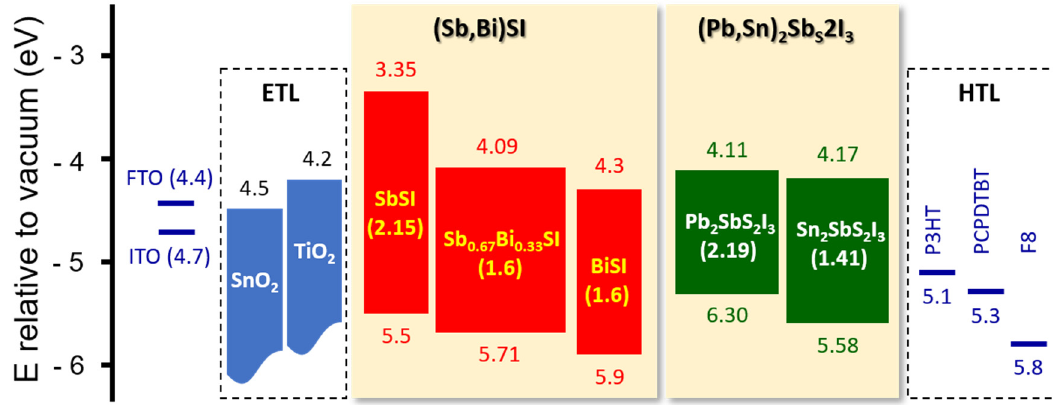
Figure 1. Energy band diagram of typical Sb/Bi chalcohalides. The SbSI, Sb 0.67 Bi 0.33 SI, BiSI, Pb 2 SbS 2 I 3 , and Sn 2 SbS 2 I 3 energy levels were obtained from [23,38,47,54] and [24], respectively. For comparison, the energy levels for typical conducting oxides (F-doped SnO 2 (FTO) and In-doped SnO 2 (ITO)), the electron transporting layer (ETL), and hole transporting layer (HTL) are included. P3HT, PCPDTBT, and F8 denote poly(3-hexylthiophene), poly[2,6-(4,4-bis(2-ethylhexyl)-4 H -cyclopenta[2,1-b;3,4-b’]dithiophene)-alt-4,7-(2,1,3-benzothiadiazole)], and poly(9,9-di-n-octylfluorenyl-2,7-diyl), respectively.